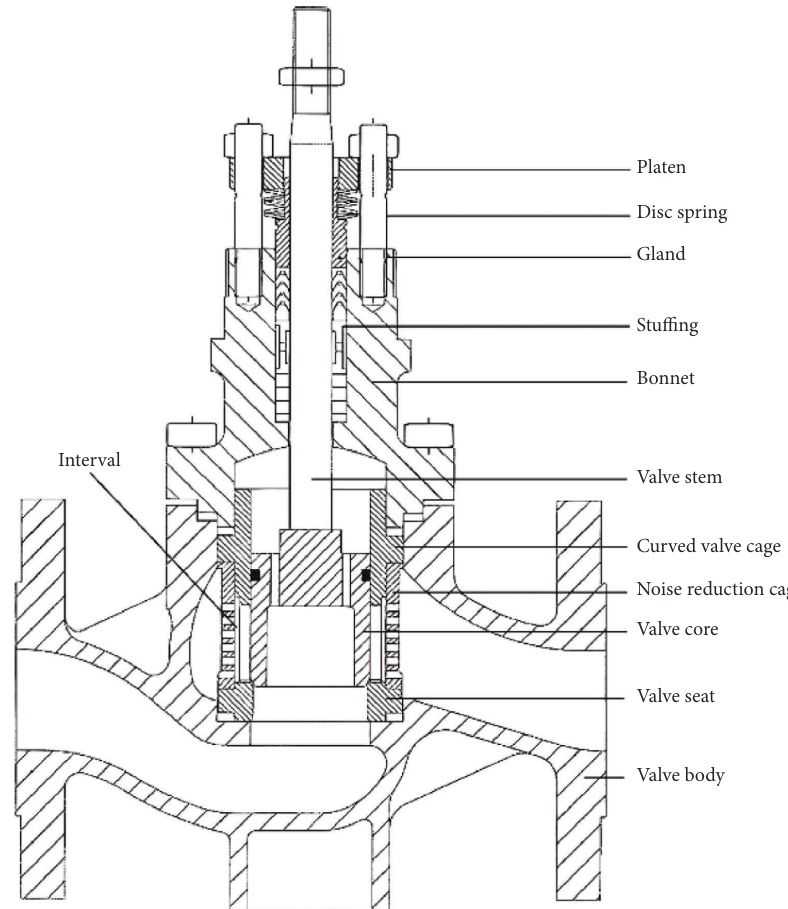
Figure 1: Noise-reducing two-stage cage control valve